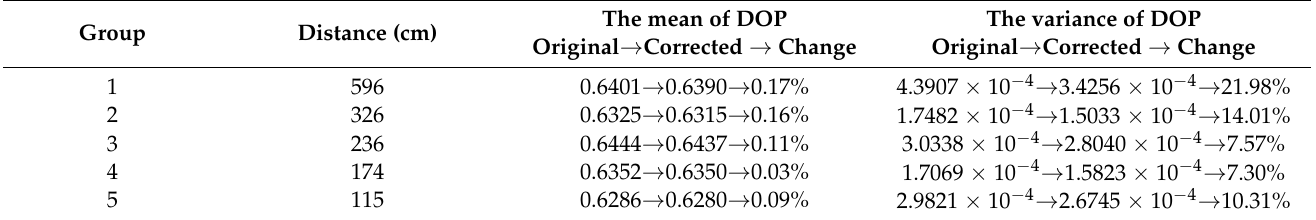
Table 1. Comparison, before and after DOP correction, of target 1 at an incident angle of 45 ◦ .